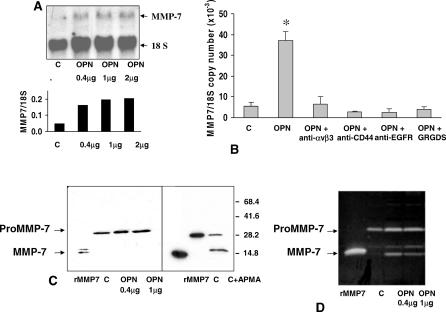
Effect of Osteopontin on MMP-7 Gene and Protein Expression and Activity in A549 Epithelial Cells(A) Northern blot of 20 μg total cellular RNA per lane extracted from control and A549 cells stimulated with 0.4, 1, and 2 μg/ml osteopontin.(B) Densitometry of Northern blot and normalization of MMP-7 to 18S demonstrates a 3- to 4-fold increase in MMP-7 over control.(C) Real-time PCR showing up-regulation of MMP-7 expression by osteopontin (*p < 0.01) and inhibition by anti-αvβ3, anti-CD44, anti-EGFR, and GRGDS.(D) Western blot demonstrating an increase of immunoreactive MMP-7 in conditioned medium from A549 epithelial cells stimulated with osteopontin. Activation of pro-MMP-7 by APMA is shown in leftmost lane.(E) Zymography of conditioned media in 12.5% SDS gels containing bovine CM-transferrin (0.3 mg/ml) and heparin as substrate.C, control; OPN, osteopontin.